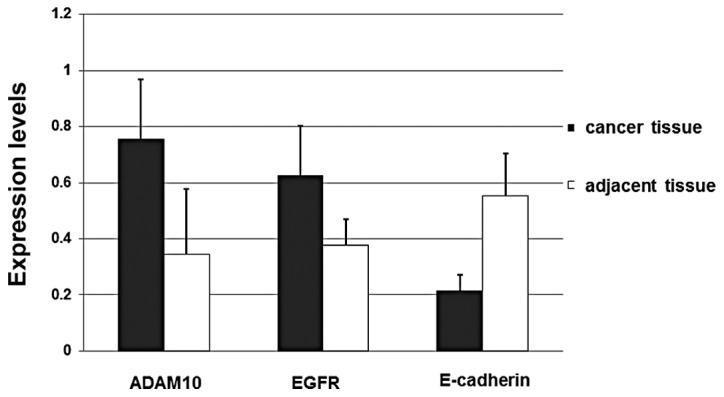
Quantitative polymerase chain reaction (qPCR) results. Total RNA was extracted. The primers and internal reference primers were synthesized by the Shanghai Allcare Biomedical Development Co,. Ltd. (Shanghai, China) and the Ct value comparison method was used to detect the gene expression level with β-actin as internal reference. The relative expression levels of a disintegrin and metalloproteinase 10 (ADAM10), epidermal growth factor receptor (EGFR) and E-cadherin were calculated with the Ct value referring to the number of cycles when the fluorescence signal reached the set threshold in each reaction.